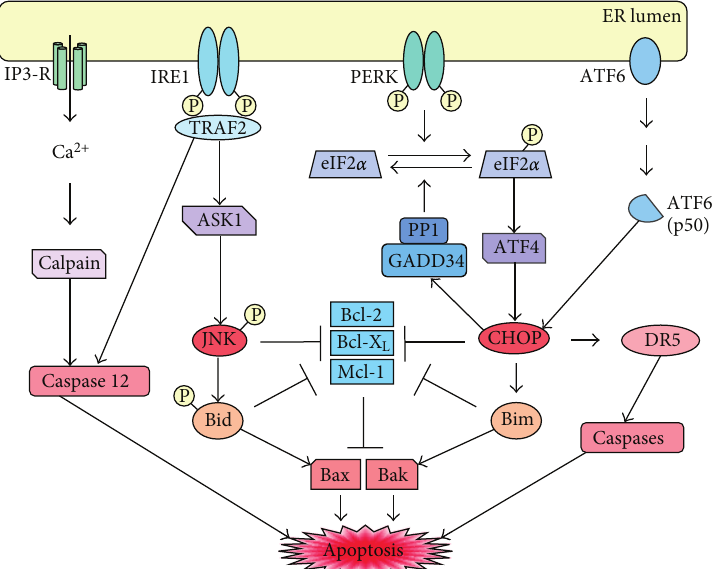
F3: Celldeath signalingbytheER stressresponse/UPR. Incase ofsevereandsustained ERstress,anumber ofproapoptotic eventsbegin to dominate and lead to apoptosis. Transcription factors ATF4 and ATF6-p50 stimulate CHOP expression. On one hand, CHOP stimulates expressionofGADD34,whichassociateswithPP1,resultingindephosphorylationofeIF2 ,thusreactivatingglobalcellularproteinsynthesis. On the other hand, CHOP inhibits antiapoptotic proteins of the Bcl-2 family and stimulates pro-apoptotic Bim, altogether leading to heterodimerization and activation of pro-apoptotic Bax and Bak. CHOP also stimulates expression of cell surface death receptor DR5, which 𝛼𝛼 sensitizes cells to pro-apoptotic stimuli, presumably via calibrating the extrinsic apoptotic pathway involving caspase 12. Similarly, activated JNK complements the pro-apoptotic efforts of CHOP. JNK becomes phosphorylated and activated by protein kinase ASK1 upon association of TRAF2 with activated IRE1. Association of TRAF2 with activated IRE1 also leads to activation of caspase 12. Calcium release from the ER via IP3 receptors can activate calpains, which further stimulate caspase 12 activation via proteolytic cleavage of its inactive procaspase